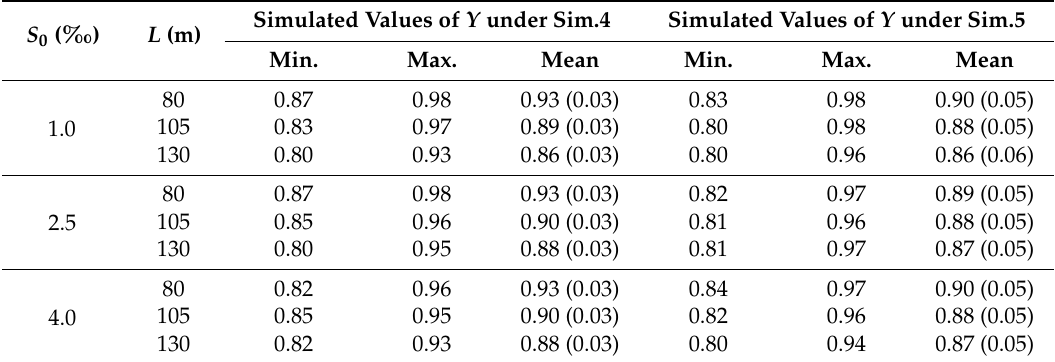
Table 3. Simulated comprehensive indicator of irrigation performance determined using WinSRFR and according to the optimal results of discharge yielded under Sim.4 and Sim.5. Simulated Values of Y under Sim.4 Simulated Values of Y under